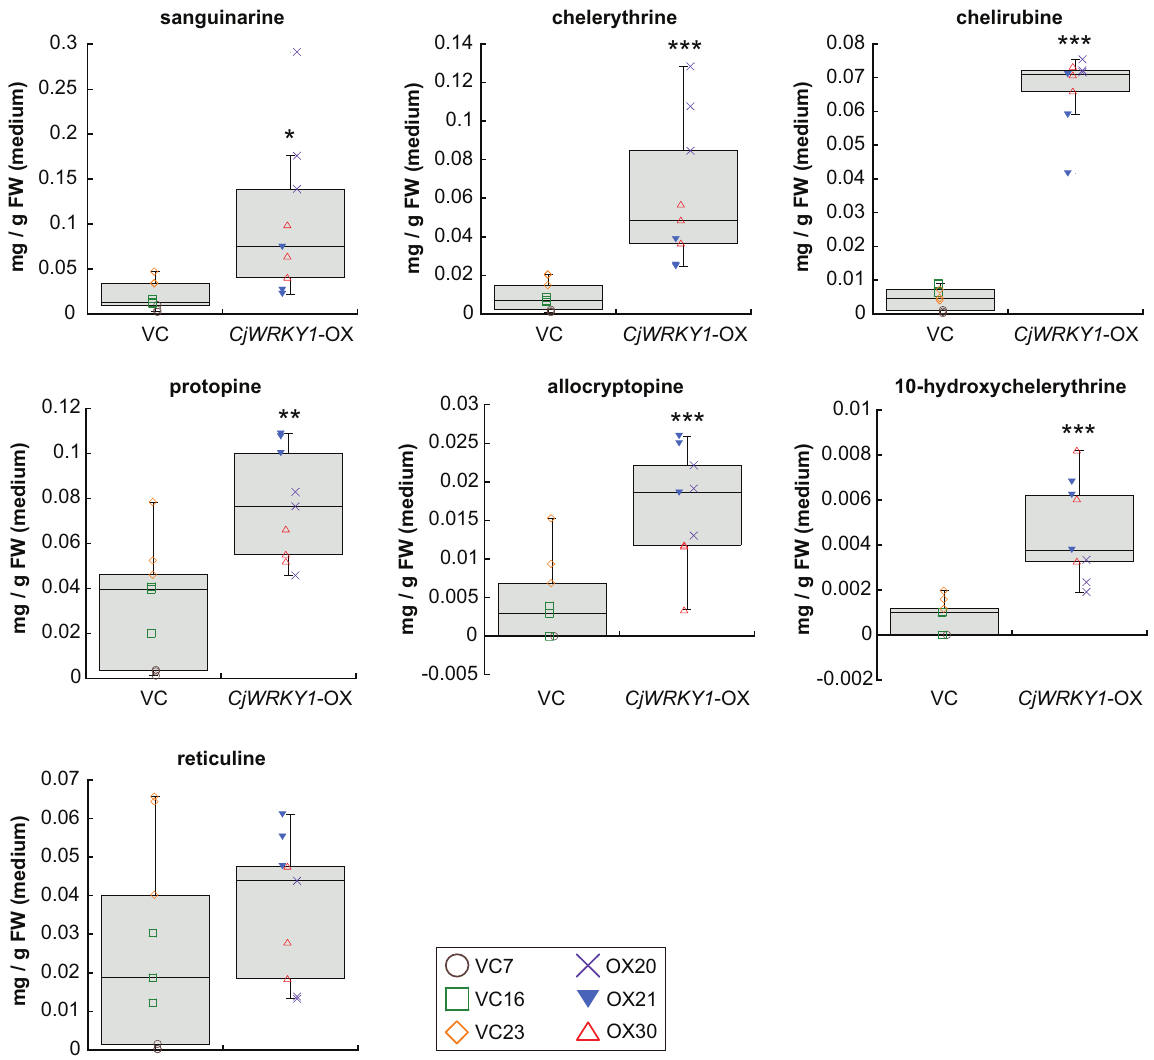
Fig 5. The accumulation of BIAs in the medium from transgenic California poppy cell lines. The contents of sanguinarine, chelerythrine,chelirubine, protopine,allocryptopine, 10-hydroxychelerythrine, and reticulinewere estimated based on the peak areas using the standardcurve created from an authentic sanguinarine sample. For each cell line, nine biological replicates were used. Asterisks indicatesignificant differences from VC cell lines ( * P < 0.05, ** P < 0.01, *** P < 0.001; two-tailed pairedStudent’s t -test).